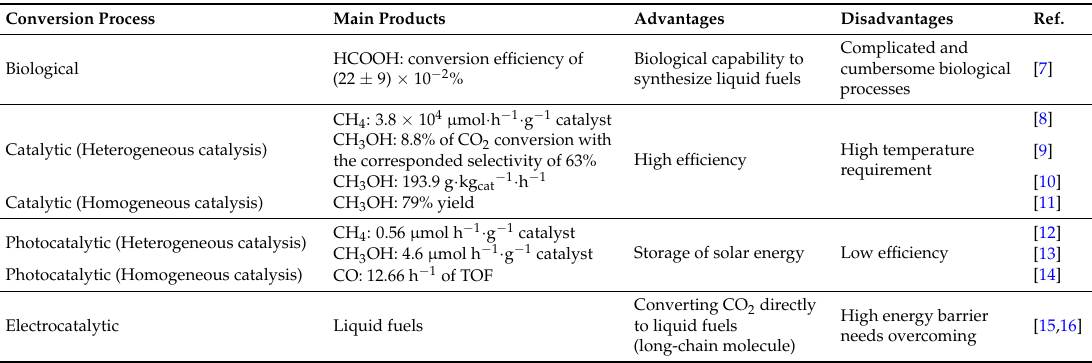
Table 1. Summary of different processes of CO 2